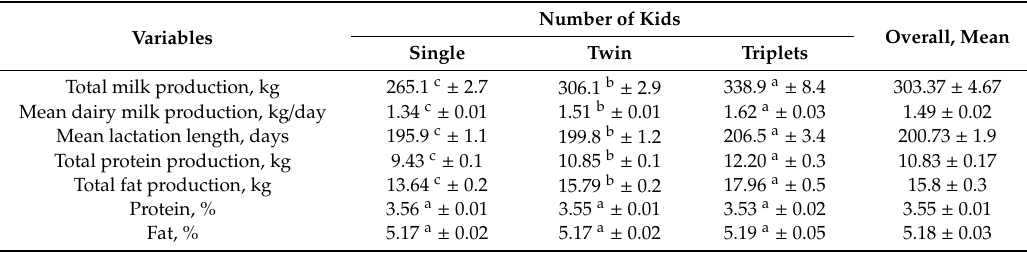
Table 4. Least square means values for studied variables across the di ff erent levels of the number of kids factor.